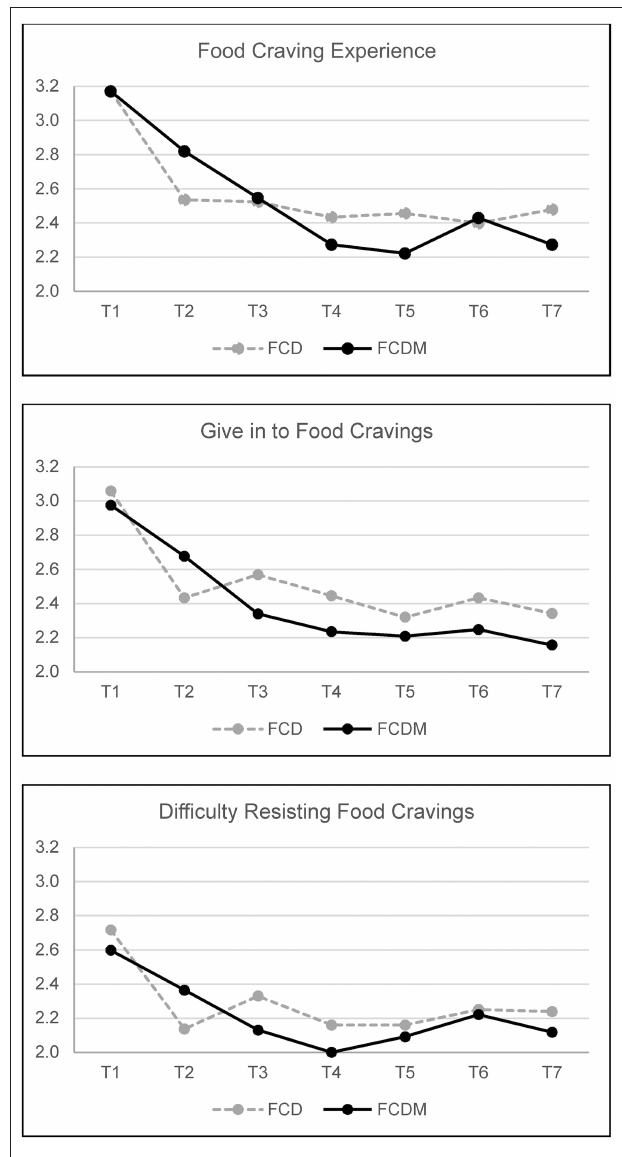
FIGURE 2 | Food cravings across a 7-day intervention (FCD, n = 88; FCDM, n =